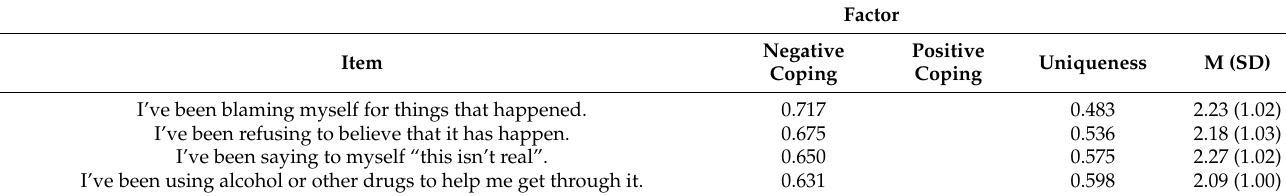
Table A2. Factor Analysis of the Brief COPE Inventory (N =